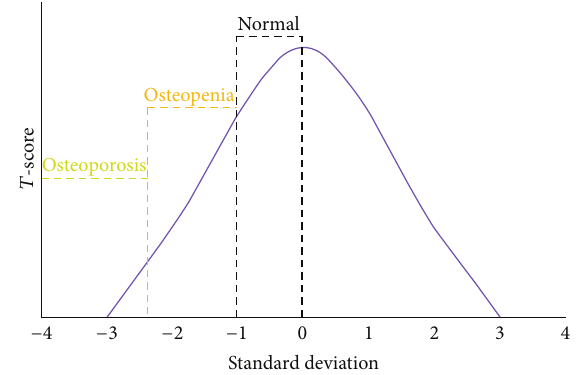
Figure 1: Standard distribution of 𝑇 -score based on DEXA standard outcomes. Within 1 standard deviation of the normal healthy 30- year-old female standard, 𝑇 -score of − 1 is considered normal. 𝑇 - score of − 2 or two standard deviations less than the standard is considered osteopoenic, and 𝑇 -score of − 2.5 or less is considered